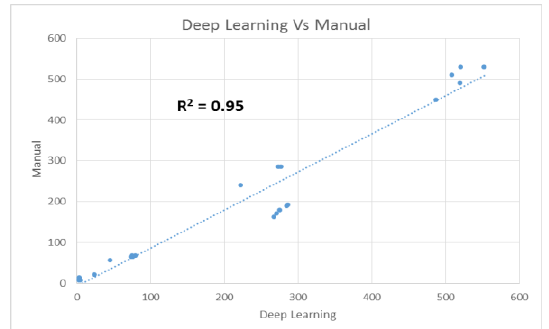
Figure 20 Deep Learning Count with Manual Count Figure 20 shows scatter graph of deep learning count vs manual count with trending line and R 2 value.